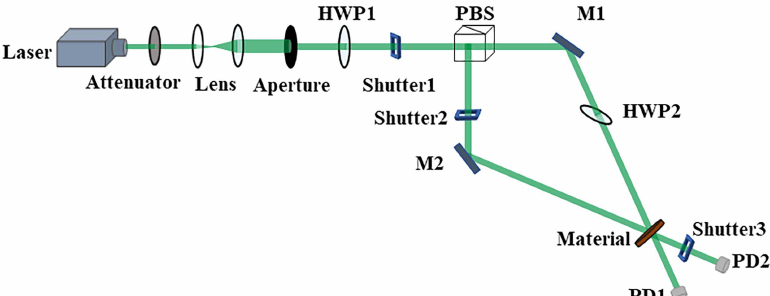
Figure 7. Experimental device for the diffraction efficiency of photopolymer materials. M, HWP,